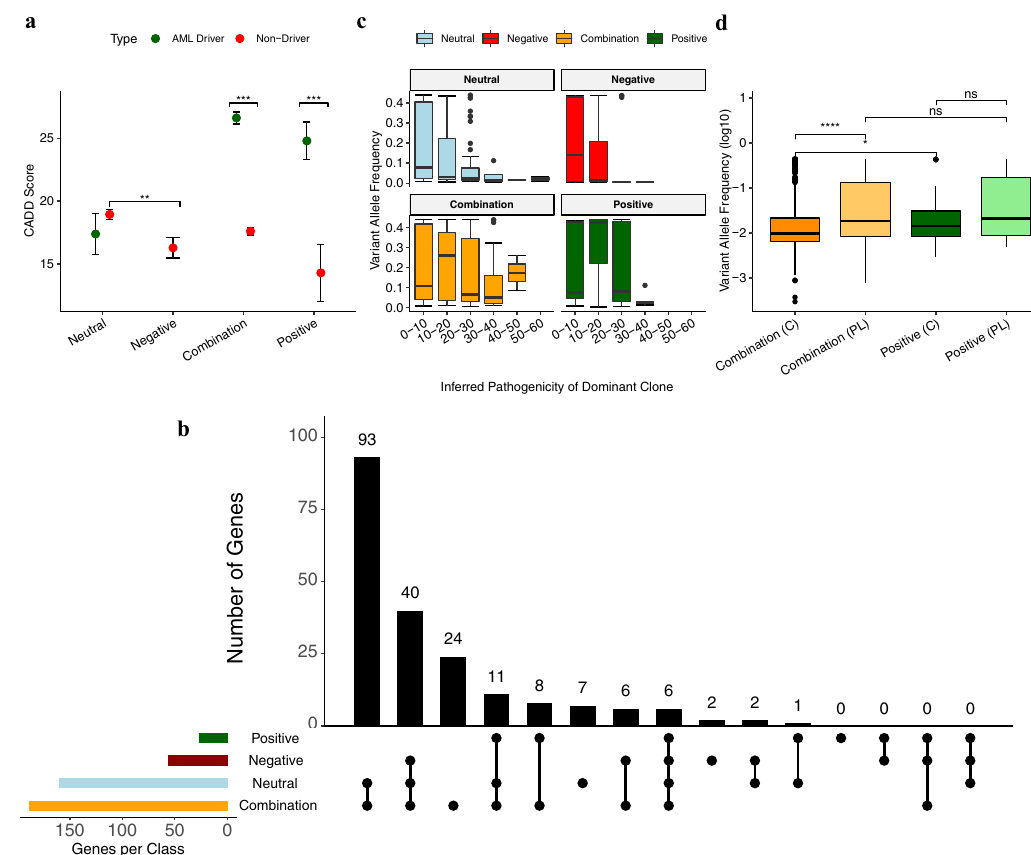
Fig. 3 Distinct patterns of inferred pathogenicity and clonal dynamics are associated with evolutionary class predictions. a Predicted functionality of mutations in each evolutionary class. Average CADD scores were calculated for mutations in known driver genes (green) and non-driver genes (red) and are presented as mean values + / − SEM. The level of signi fi cance is indicated as follows: ns: p > 0.0, * p -value < = 0.05, ** p -value < = 0.01, *** p -value < = 0.001, **** p -value < = 0.0001. We capture a signi fi cant (Two-sided Wilcoxon rank-sum test, positive models: W = 548, p -value = 0.001; combination models: W = 278136, p -value < 2.2e − 16) enrichment of high CADD scores in driver genes compared to non-driver genes. We do not observe a signi fi cant difference between CADD scores across mutations in driver genes and non-driver genes in neutral classes (Two-sided Wilcoxon rank-sum test, W = 7598.5, p -value = 0.3), The average CADD score assigned to passenger mutations in negative models is signi fi cantly lower (Two-sided Wilcoxon rank- sum test, W = 39298, p -value = 0.004) than passenger mutation CADD scores in the neutral class. b Distribution of function-altering mutations in genes across evolutionary classes. The UpSet plot shows the distribution of function-altering mutations (CADD > 10) falling in genes across patients in different evolutionary classes. The total number of genes mutated in each evolutionary class is shown on the left (positive = green, negative = red, combination = orange, neutral = blue). The dark circles indicated classes with overlapping genes and the connecting bar indicated multiple overlapping genes. c Inferred pathogenicity of the dominant clones is correlated with the variant allele frequency across different evolutionary classes. We isolated the dominant clone within each individual blood pool. The CADD scores of each clone were binned into intervals of 10 and each boxplot illustrates the distribution of variant allele frequencies for each interval, the midline represents the medians, the upper and lower bounds the interquartile ranges, and the whiskers extend to 1.5 times the interquartile range. Plots are faceted according to evolutionary class (positive ( n = 30): green, negative ( n = 65): red, combination ( n = 229): orange, neutral ( n = 158): blue). We observe a wider distribution of CADD scores in neutral and combination models. In positive classes of evolution, clones are found at a higher frequency suggesting that they sweep to fi xation. Similarly, in negative models of evolution, we observe a surplus of clones in the low CADD score bins which appear to segregate at a lower frequency. d Impact of Negative Selection on Clonal Expansions. We investigated if negative selection acting on passenger mutations impacted clonal expansions in a healthy and preleukemic context. To do so, we plotted the log-transformed variant allele frequency (VAF) of mutations found in cases and controls predicted to be evolving in positive class (green) and combination (orange) classes. Each boxplot illustrates the distribution of log10-transformed VAFs for each group, the midline represents the medians, the upper and lower bounds the interquartile ranges, and the whiskers extend to 1.5 times the interquartile range. The evolutionary class is denoted on the x -axis (combination/positive) and preleukemic/control status is indicated by a (PL) or (C), respectively. The level of signi fi cance is indicated as described above. VAF distributions were plotted separately for preleukemic individuals (light green/ light orange) and healthy controls (dark green/dark orange). We fi nd that we are not able to discriminate between VAF distributions of mutations in healthy and preleukemic individuals in the positive class. Further, we are not able to discriminate between positive models of evolution and preleukemic individuals who fi t combination models of evolution. However, we fi nd that clones in controls fi tting combination classes of evolution have a signi fi cantly lower VAF distribution compared to both preleukemic cases fi tting combination models (Two-sided Wilcoxon rank-sum test, W = 254988, p -value < 2.2e − 16, n combination(PL) = 403, n combination(C) = 1095) and clones in controls fi tting positive models (Two- sided Wilcoxon rank-sum test, W = 25180, p -value = 0.02, n positive(c) = 34).